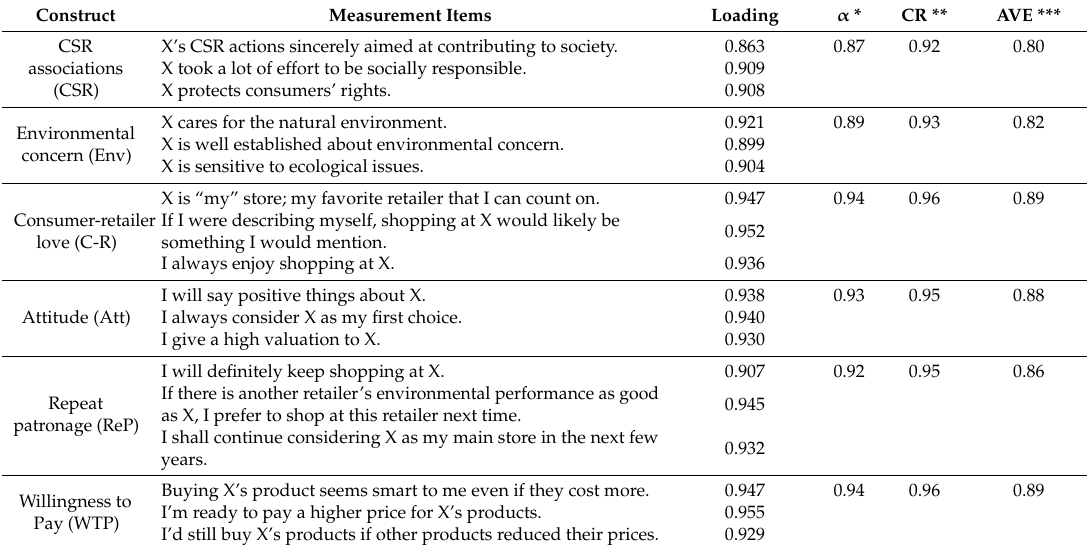
Table 1. The constructs and their measurement